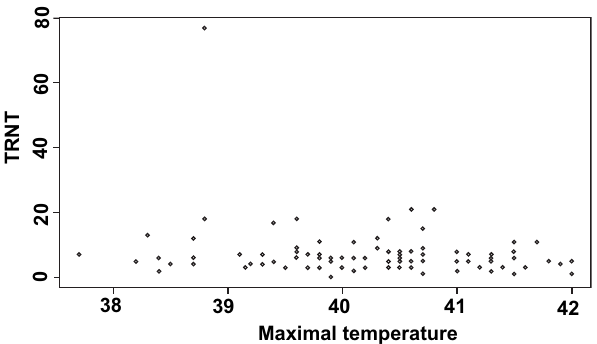
Figure 11. Time to removal of nasogastric tube (TRNT) (days) versus Tmax ( ° C). Scatterplot showing the relation between TRNT and Tmax. Table 9. Model predicting the logarithm of the hazard of death (HR: Hazard ratio; SE: Standard error).